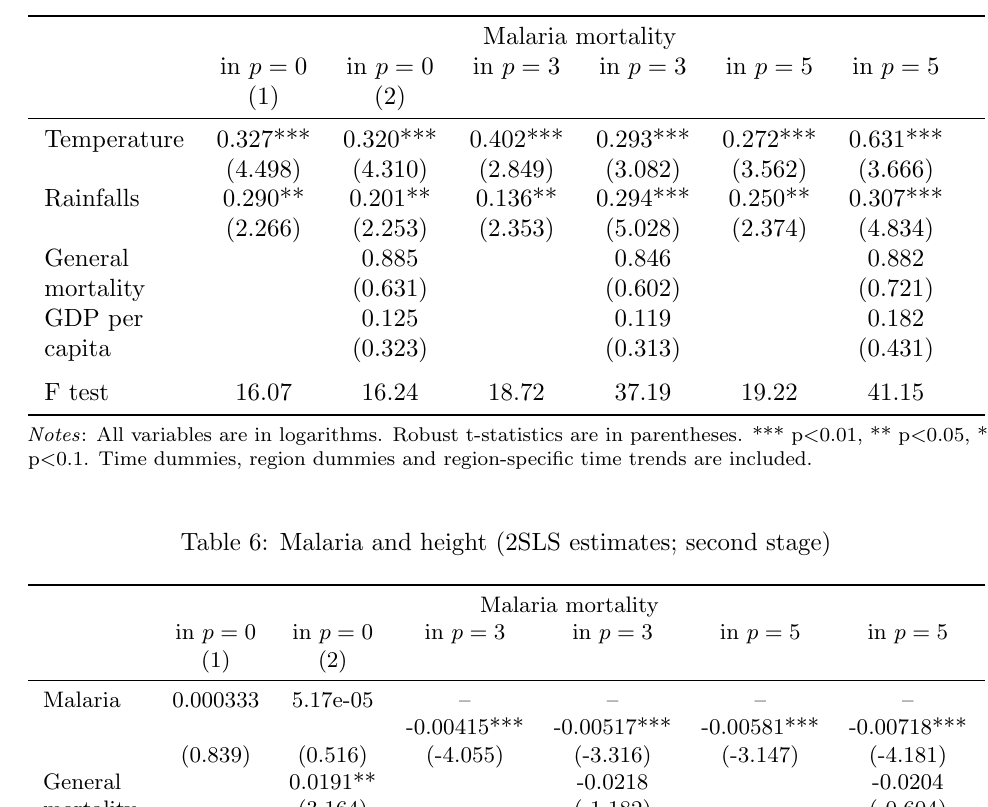
Table 5: Malaria mortality and climatic variables (2SLS estimates; first stage regressions)